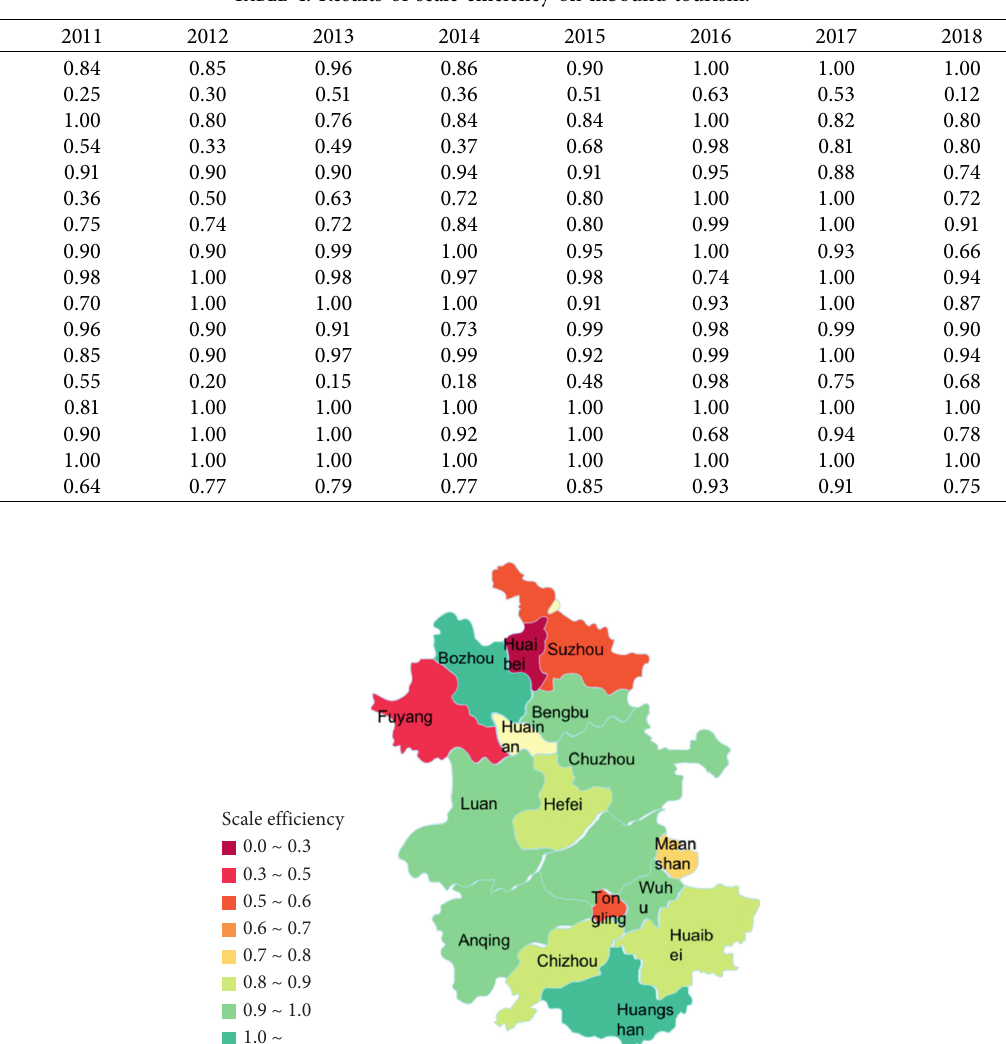
Table 4: Results of scale efficiency on inbound tourism.